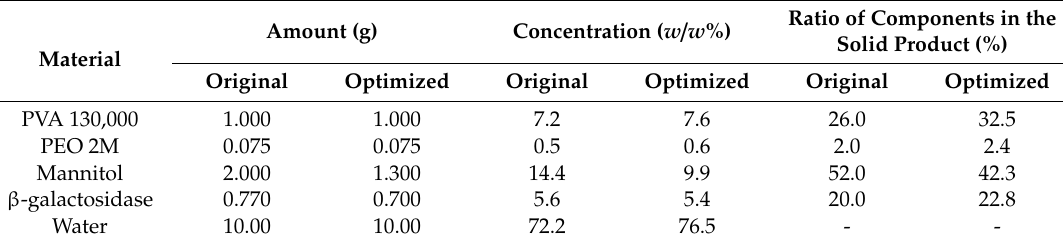
Table 1. Composition of the PVA-based electrospinning solutions of β -galactosidase.